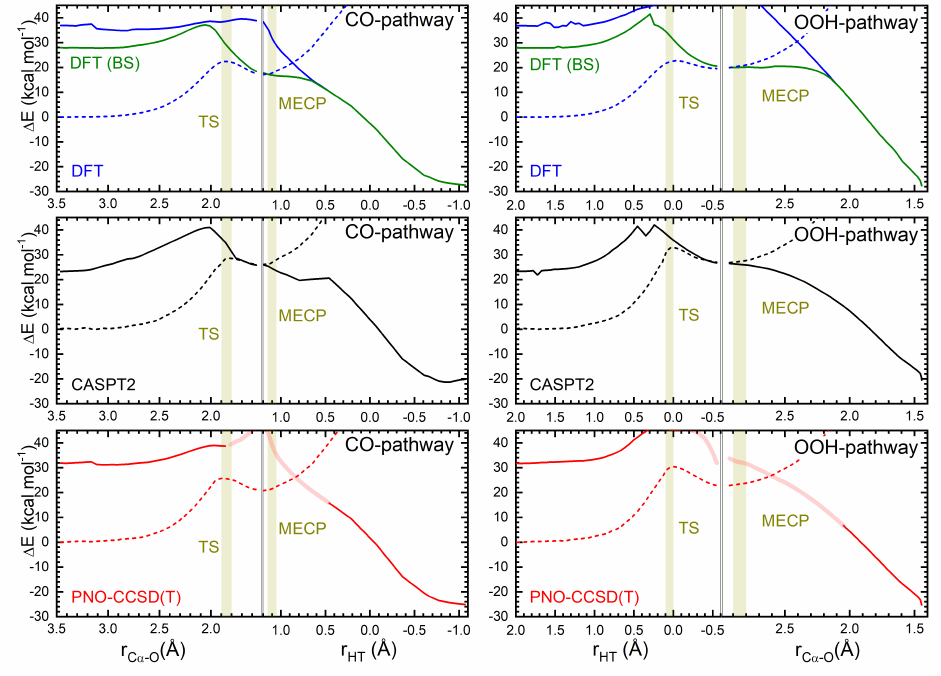
Figure 5. Energy profile for the addition of O 2 to 2-methyl-3,4-dihydro-1-naphthol along the two possible reaction paths at M062X-D3 (top panels), CASPT2(8,5) (middle panels), and DLPNO-CCSD(T) (bottom panels). Dashed and solid lines denote triplet and singlet states, respectively. For DLPNO- CCSD(T) calculations, the regions where T1 diagnosis predicts a significant non-monoreference character are shown in brighter red. The basis set employed is maug-cc-pVDZ for all the